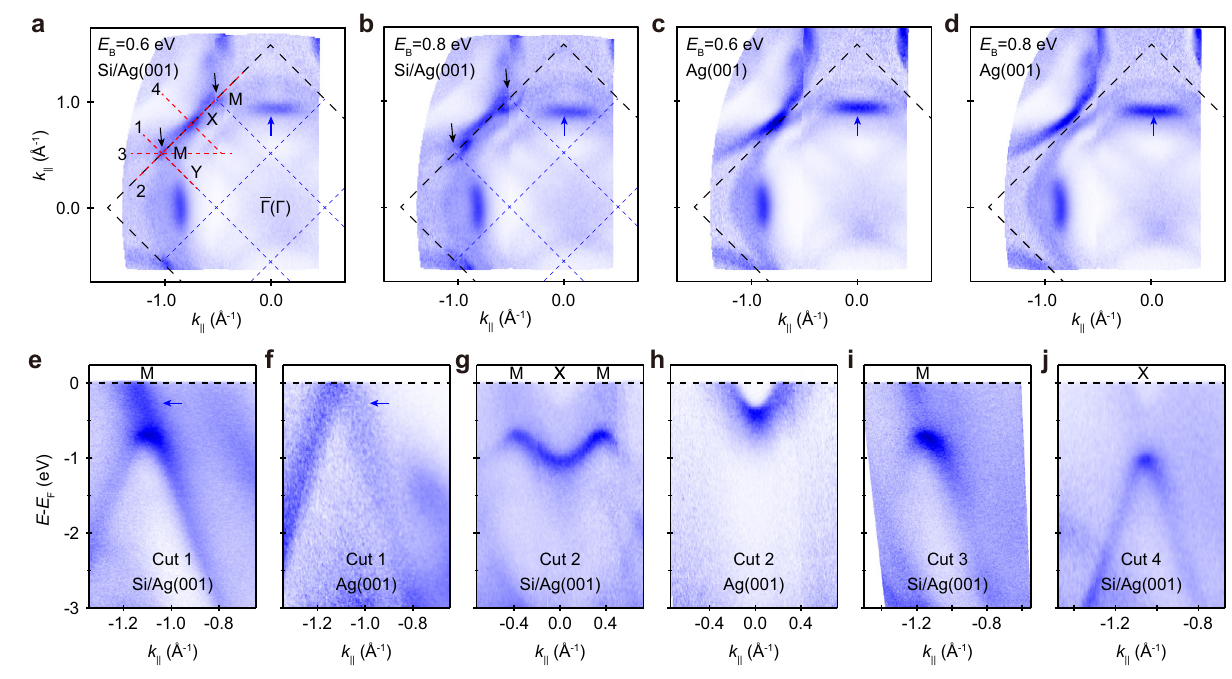
Fig. 3 | ARPES measurement of Si/Ag(001). a , b ARPES intensity plots of Si/Ag(001) at binding energies of 0.6 and 0.8eV, respectively. The red lines in a indicate the momentum cuts where ( e – j ) are taken. c , d The same as a and b but for pristine Ag(001). e – j ARPES intensity plots along Cuts 1-4 indicated in a . The